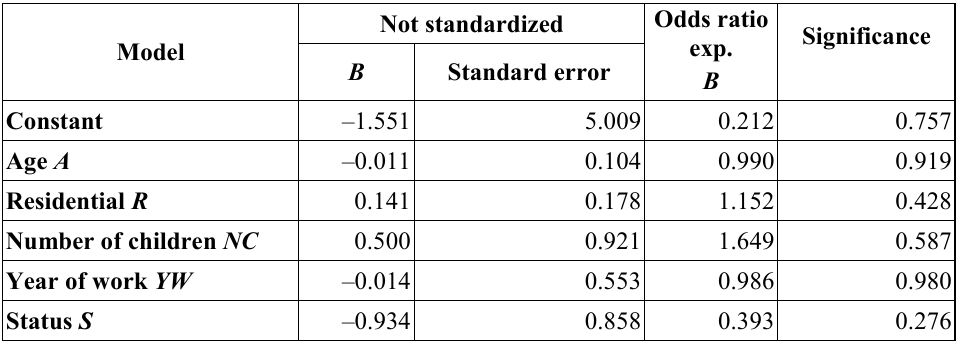
Table 9. Logistics Regression Analysis for Employee Discomfort Not standardized Odds ratio Model B Standard